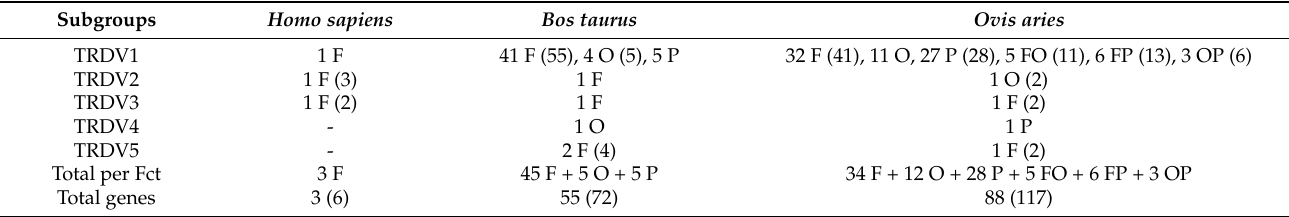
Table 9. IMGT Potential germline repertoires of the TRDV subgroups in human ( Homo sapiens ), bovine ( Bos taurus ) and sheep ( Ovis aries ).